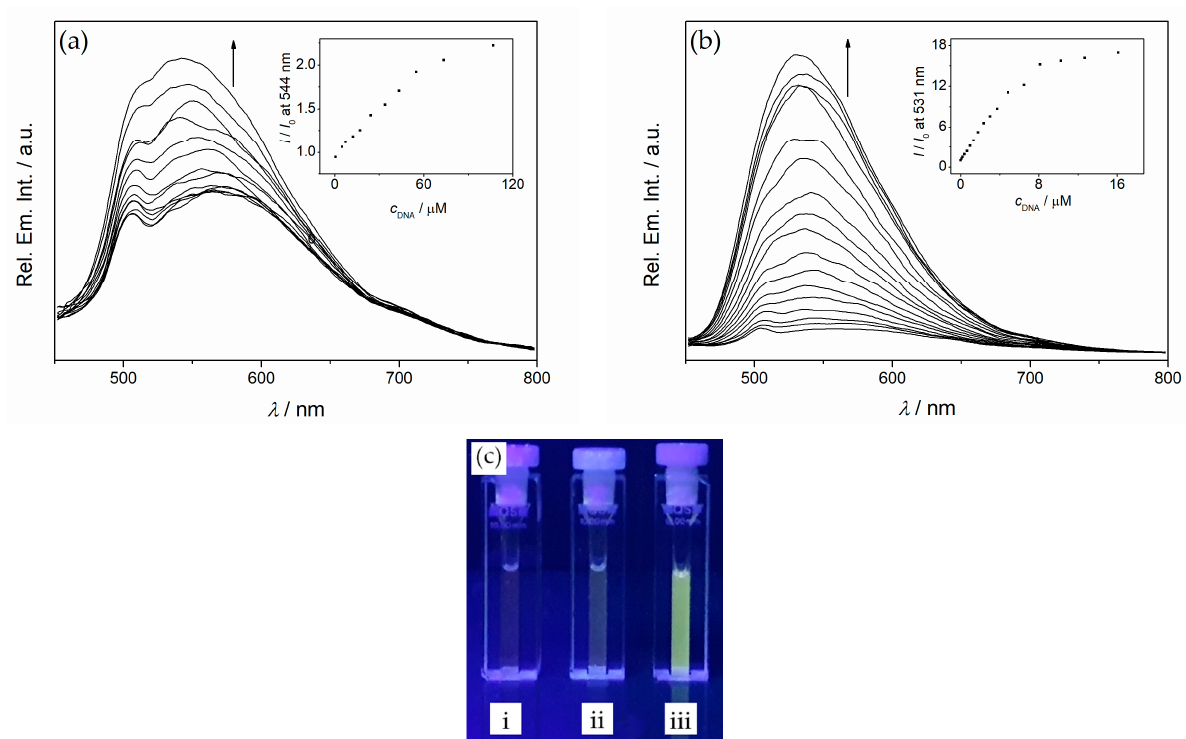
Figure 6. Fluorimetric titration of 2 ( c = 20 µM, λ ex = 430 nm) with ct DNA ( a ) in a BPE buffer ( c Na+ = 16 mM, pH 7.0, with 5% v / v DMSO) and with a2 ( b ) in a K-phosphate buffer ( c K+ = 110 mM, pH 7.0, with 5% v / v DMSO); λ ex = 430 nm. The arrows indicate the changes in absorption upon addition of DNA. Inset: Plot of the relative fluorescence intensity versus c DNA ; ( c ) pictures of the emission color of 2 in a K-phosphate buffer (i) and in the presence of ct DNA (ii) and 22AG (iii) ( λ ex = 360 nm).